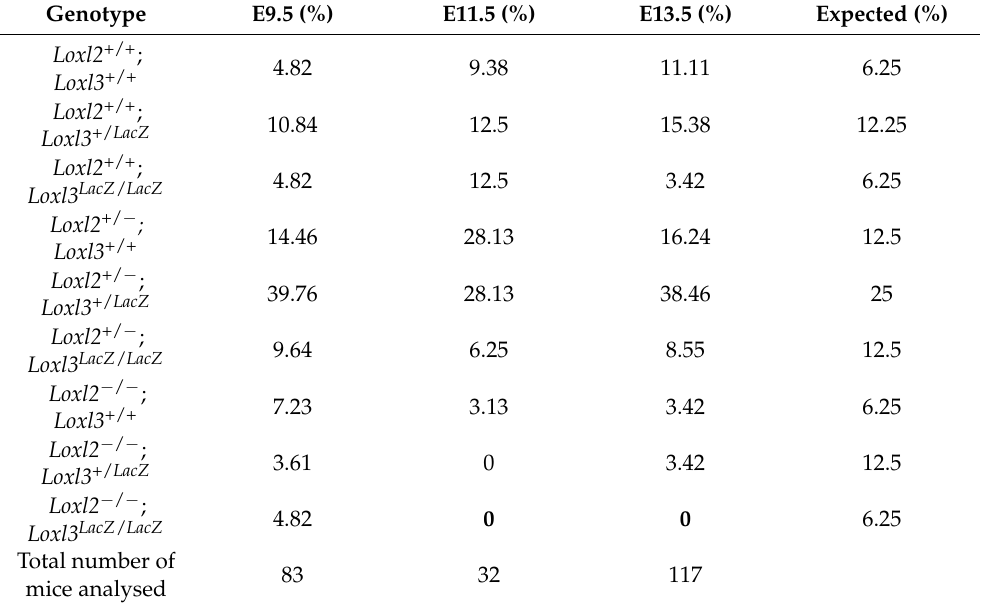
Table 3. Genotype frequency of embryos obtained from Loxl2 +/ − ; Loxl3 +/ LacZ crossings. Values reflecting the embryonic lethality associated with double Loxl2 / Loxl3 KO are indicated in